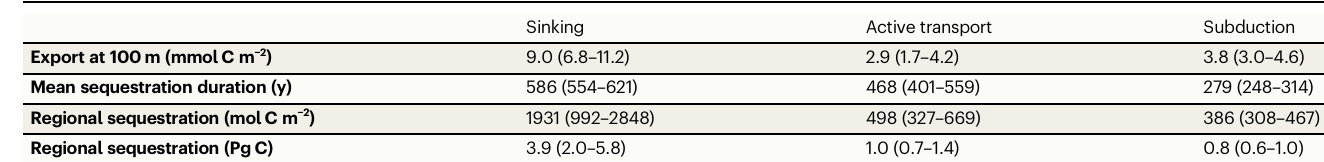
Table 1 | Regionally averaged (and 95% con fi dence limits) contributions of each biological carbon pump pathway Sinking Active transport